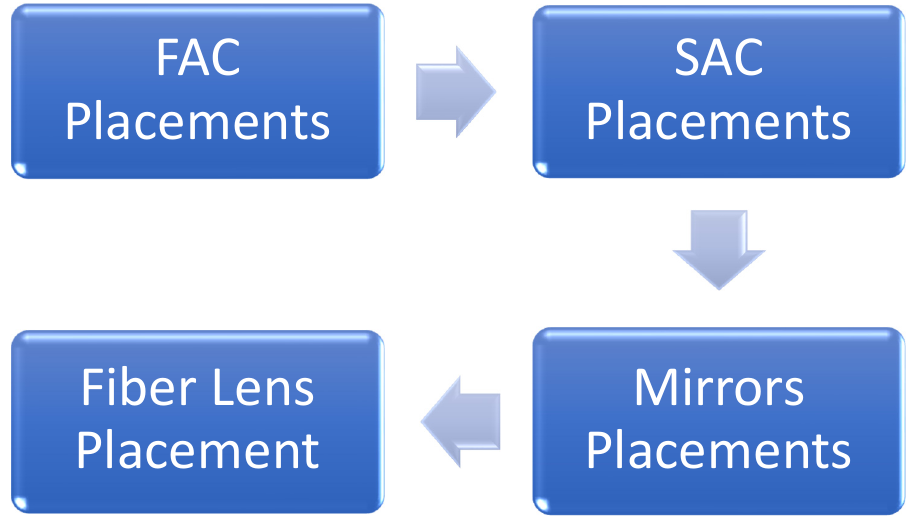
Figure 3. Assembly process from start to finish of the s-serie laser module.